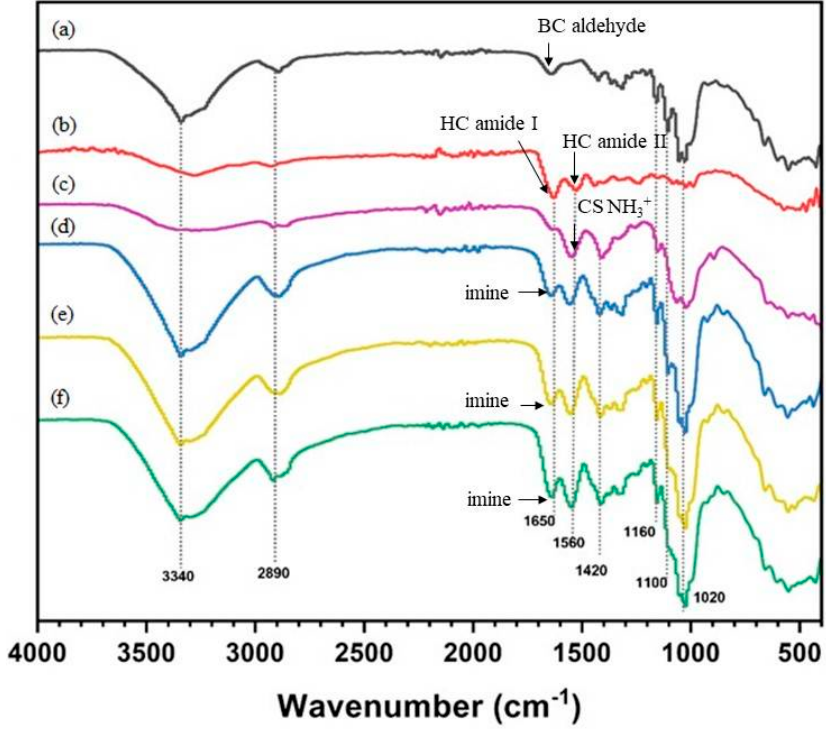
Figure 4. FTIR spectra of ( a ) BC, ( b ) HC, ( c ) CS, ( d ) CS coated BC/HC 90:10, ( e ) CS ‐ coated BC/HC 80:20, and ( f ) CS ‐ coated BC/HC 70:30.